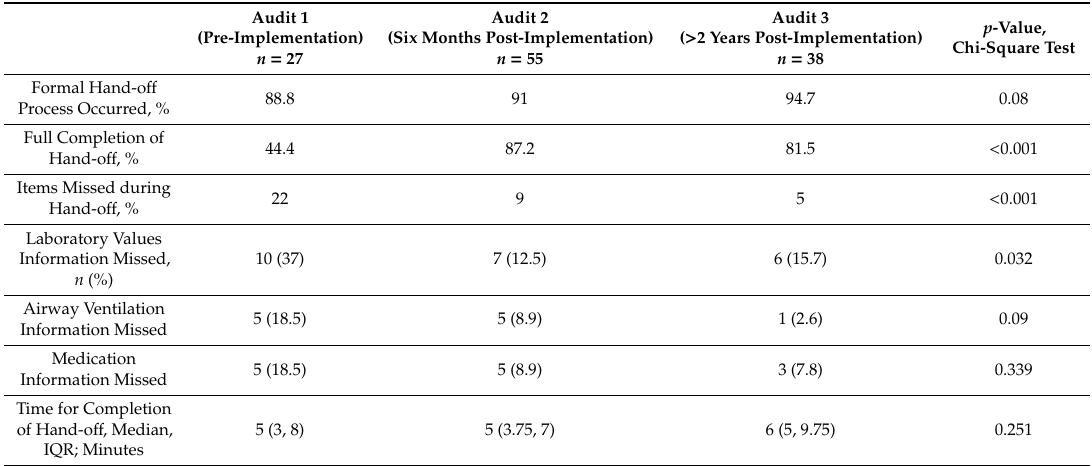
Table 3. Results of the audit regarding missed information at hand-off, IQR = Interquartile range.